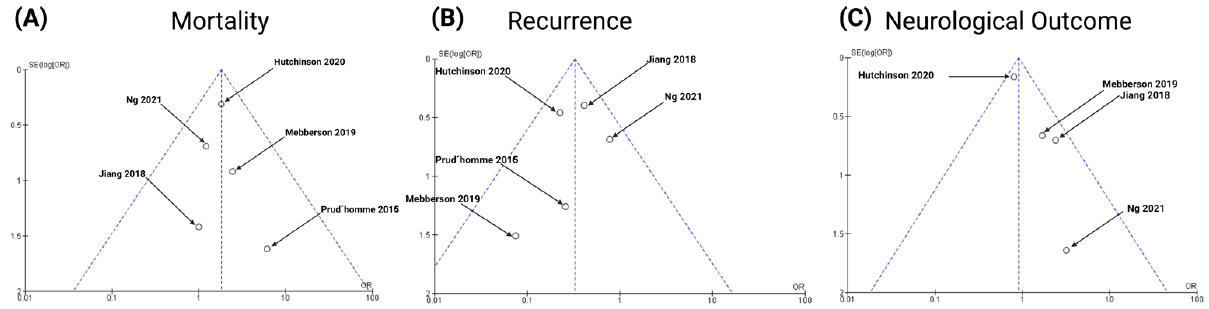
Figure 14. Funnel plots for the following endpoints of the present meta-analysis [28–32]: Mortality ( A ), Recurrence ( B ), Neurological outcome ( C ). The midline of the studies indicates no publication bias of studies comparing anti-inflammatory therapies with conventional therapy.